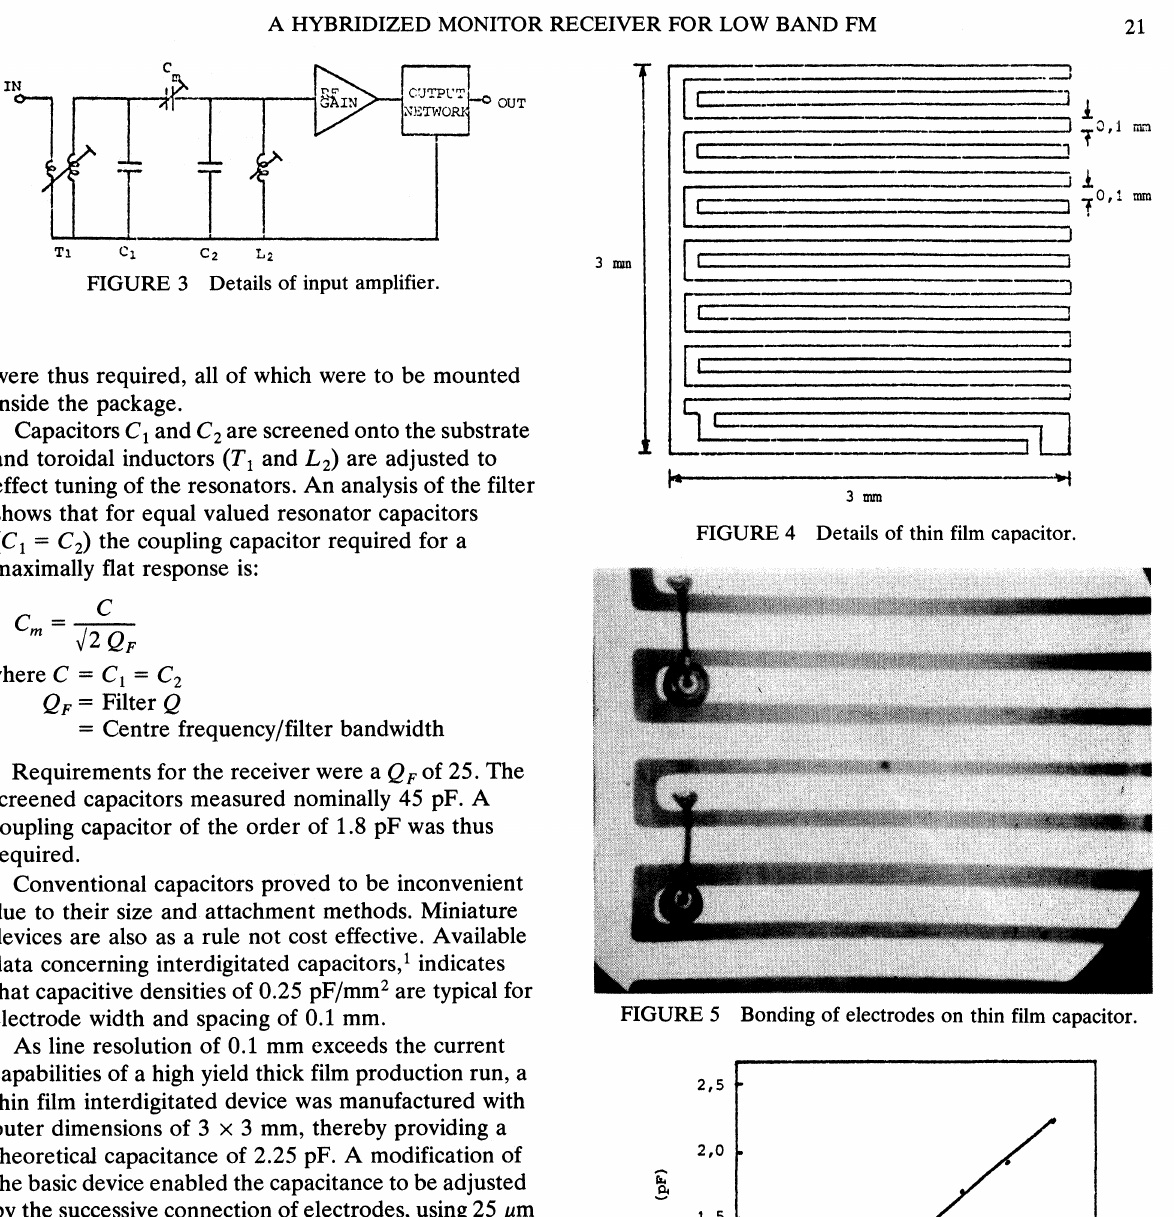
FIGURE 3 Details of input amplifier.